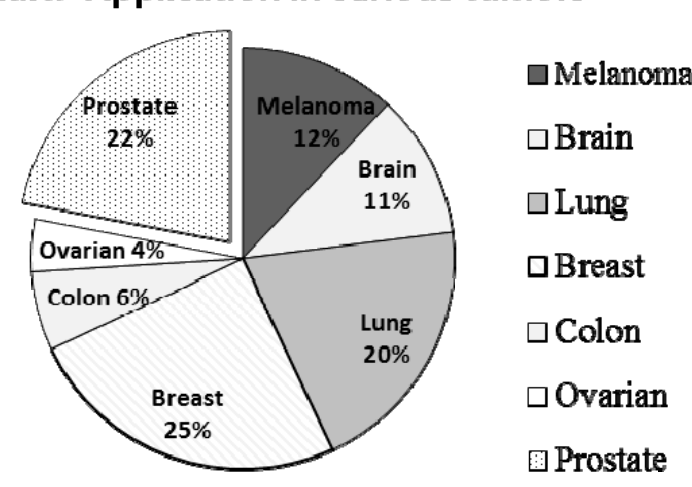
Figure 3. Proportion of gold nanoparticle (AuNP) applications in various types of cancer.